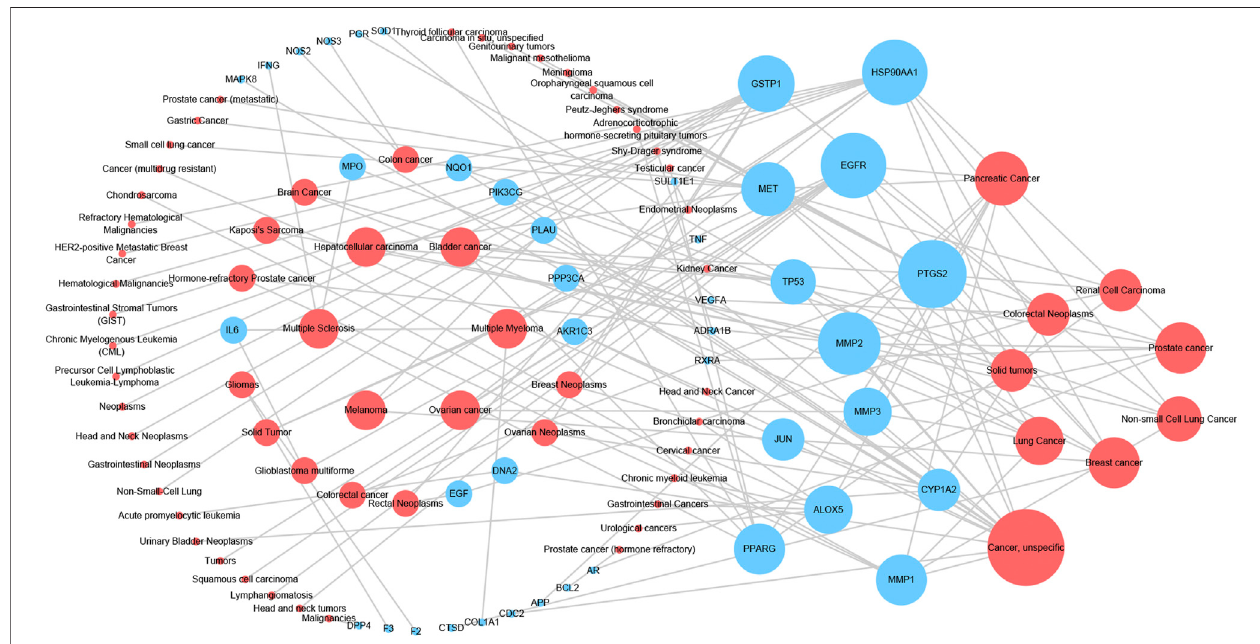
FIGURE4| Cancertarget – cancernetwork.Rednodesrepresentcancer,andbluenodesrepresentthecancer-relatedtargets.Thenodesizeisproportionaltoitsdegree.